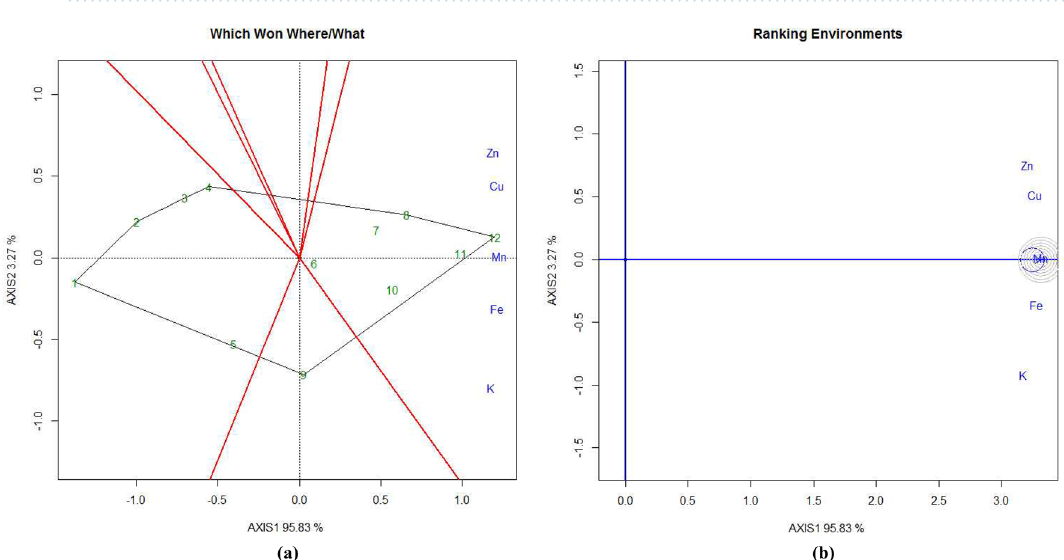
Figure 6. GGE biplot analysis of nutrient accumulation of eggplant leaf under experimental treatments. ( a ) Polygon view (which won where/what), ( b ) ranking environments. AXIS 1 Principal Component 1, AXIS 2 Principal Component 2. #1 = RDF1-MNENPK1; 2 = RDF1-MNENPK2; 3 = RDF1-MNENPK3; 4 = RDF1- MNENPK4; 5 = RDF2-MNENPK1; 6 = RDF2-MNENPK2; 7 = RDF2-MNENPK3; 8 = RDF2-MNENPK4; 9 = RDF3-MNENPK1; 10 = RDF3-MNENPK2; 11 = RDF3-MNENPK3; 12 =